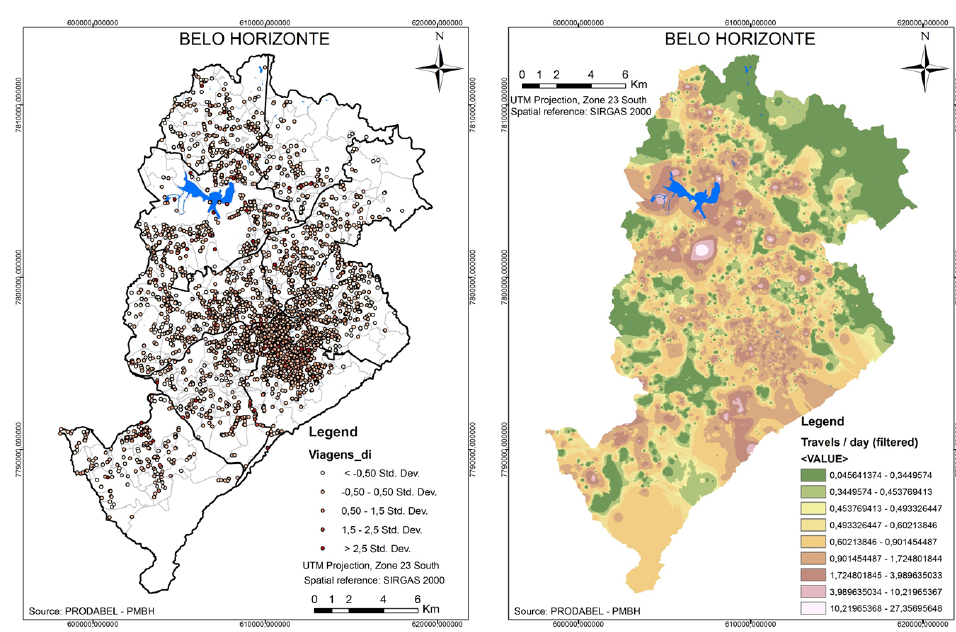
Figure 5: The geographical dispersion of deliveries to bars and restaurants in Belo Horizonte (left) and the surface of expected travel per day produced from the freight trip generation model